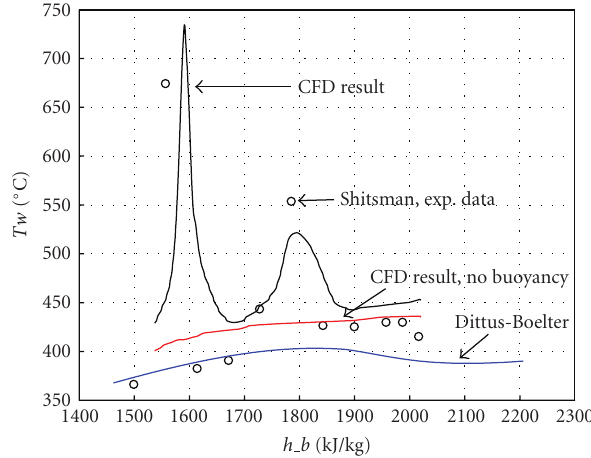
Figure 3: Comparison of the numerical results with the experiment by Shitsman [1] and the correlation by Dittus-Boelter. Flow conditions: p = 23 . 3 MPa, d = 8mm, G = 430 kg / m 2 s, q = 319 . 87 kW / m 2 , vertical upward flow in a pipe.